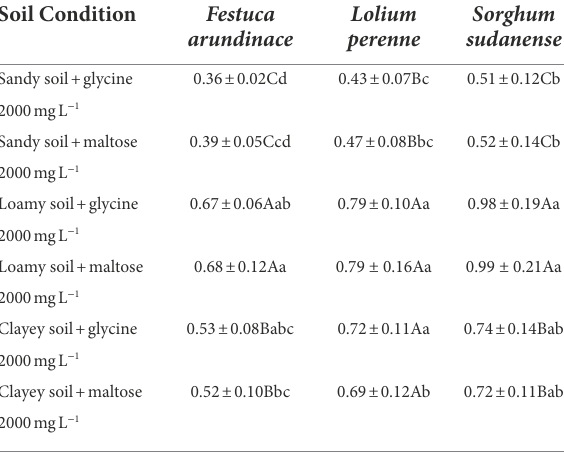
Data are the mean of three replicates ± SE. Differences sampled indicated by capital letter are between soil types, and by lower-case letter are exudates related. Means followed by the same letters are not significantly different at 5% according to Duncan’s multiple range